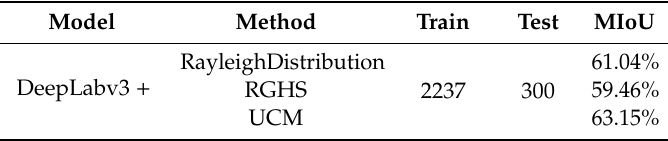
Table 6. MIoU values in di ff erent